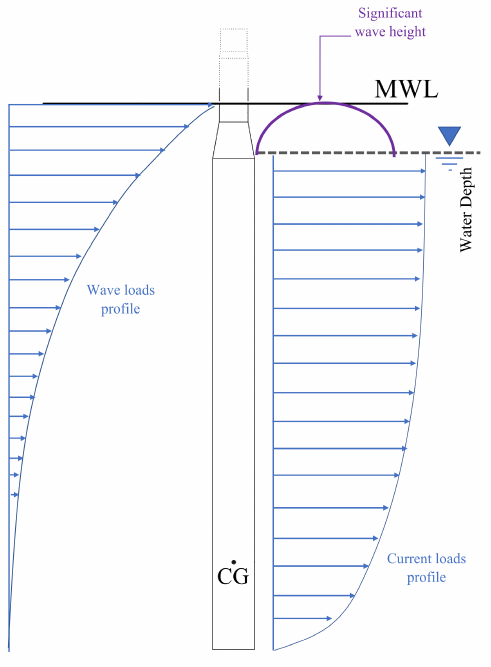
Figure 9. Schematic representation of a FOWT platform with structural properties and environmental loading parameters systems